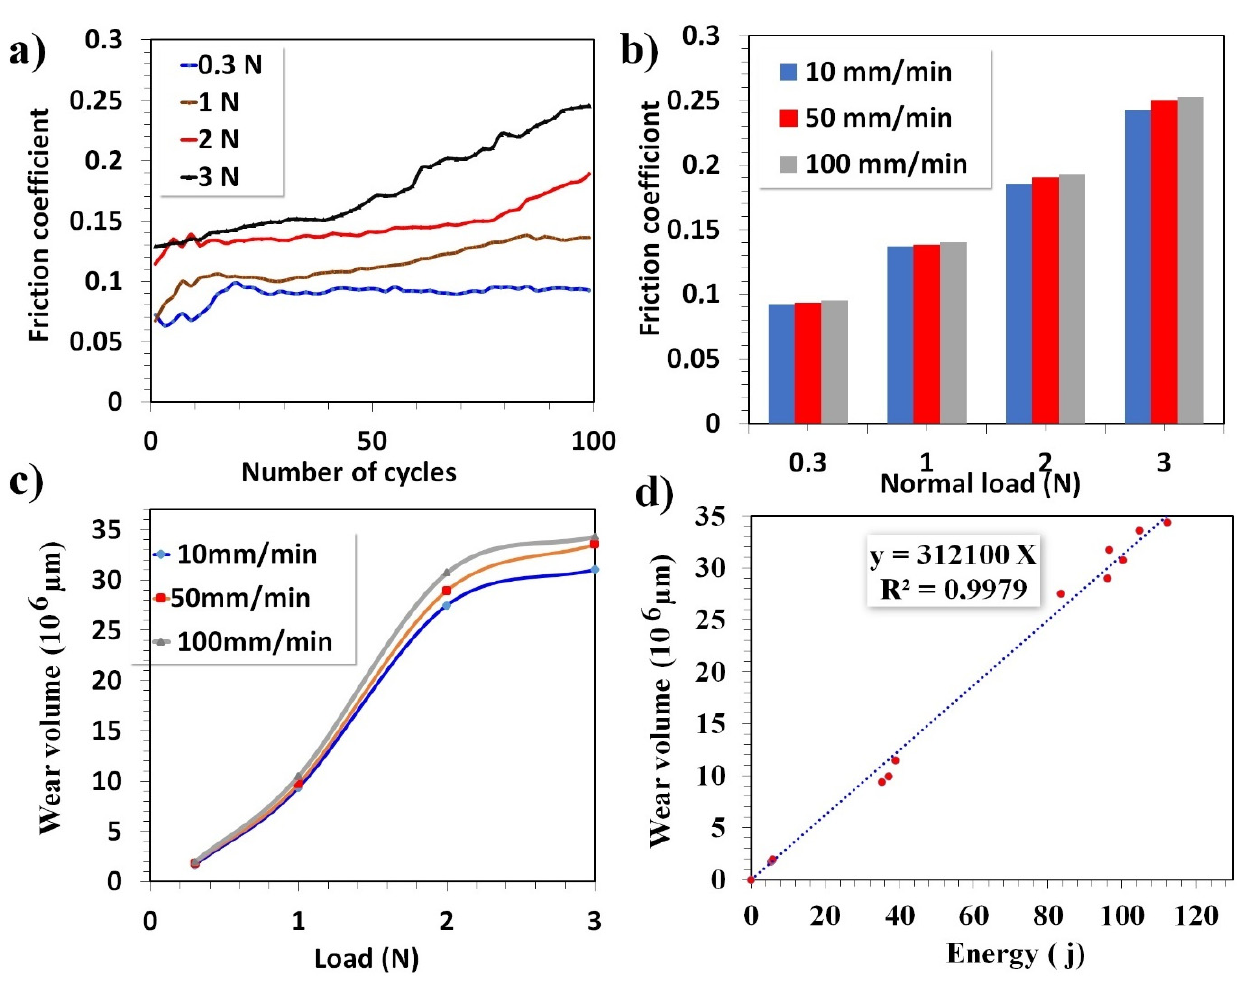
Figure 6. ( a ) COF plot of FEP coatings versus the number of cycles for 0.3, 1, 2, and 3 N at 50 mm min − 1 , ( b ) COF bar graph and ( c ) wear volume versus load after 100 passes at various velocities, and ( d ) wear volume as a function of the dissipated energy.